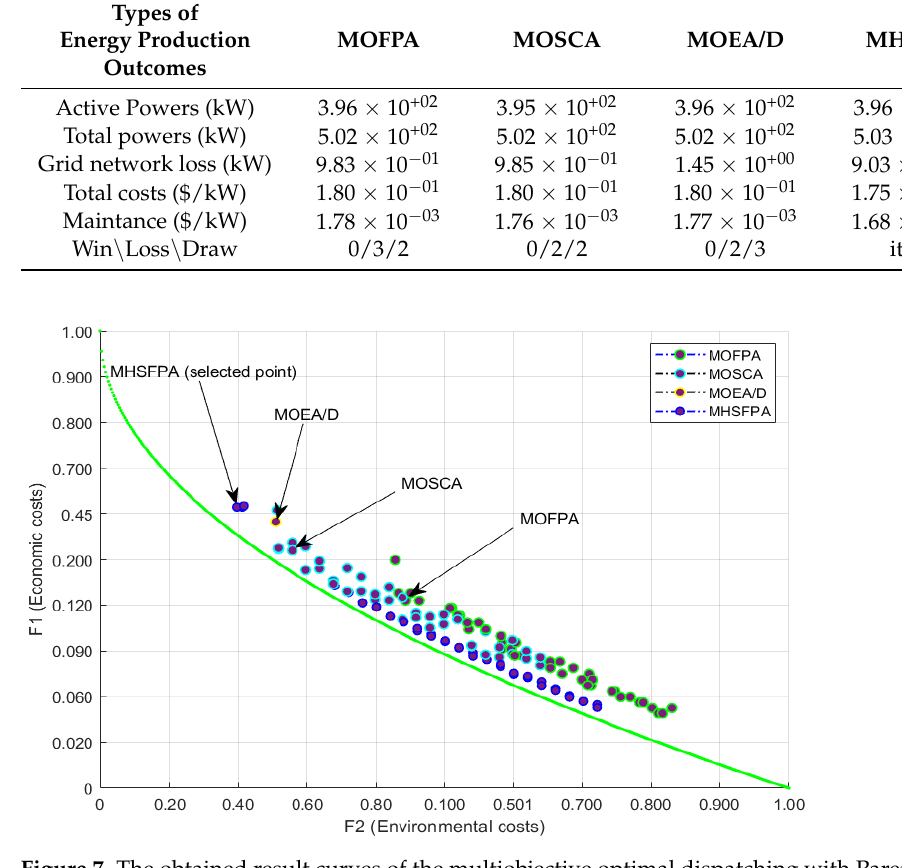
Figure 8. The planned curve results of the schemes of the HSFPA, MBGA, PSO, and AOA method- ologies according to the daily schedule.